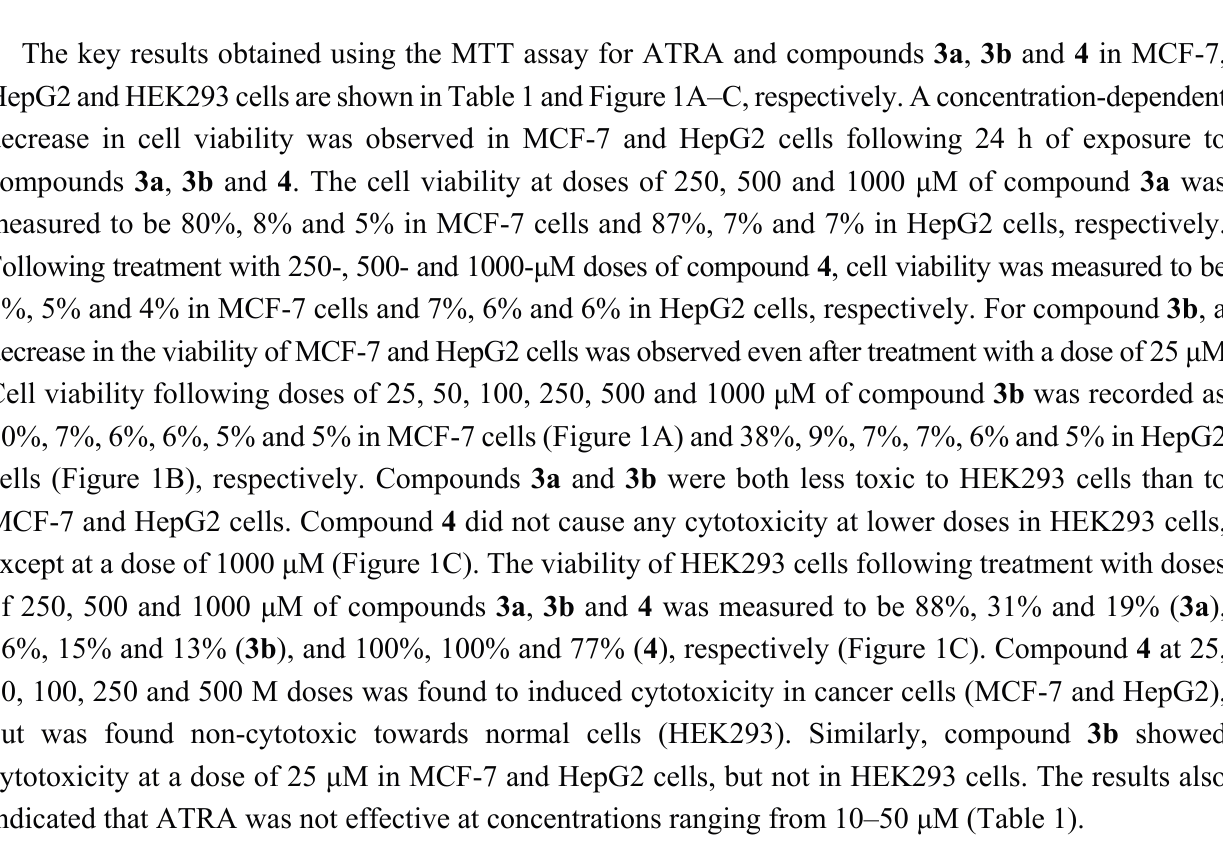
Table 1. Cytotoxicity assessments of all trans-retinoic acid (ATRA) by MTT assay in MCF-7 cells, HepG2 cells and HEK293 cells. The cells were exposed to different concentrations of ATRA for 24 h. Values are the mean ± SE of three independent